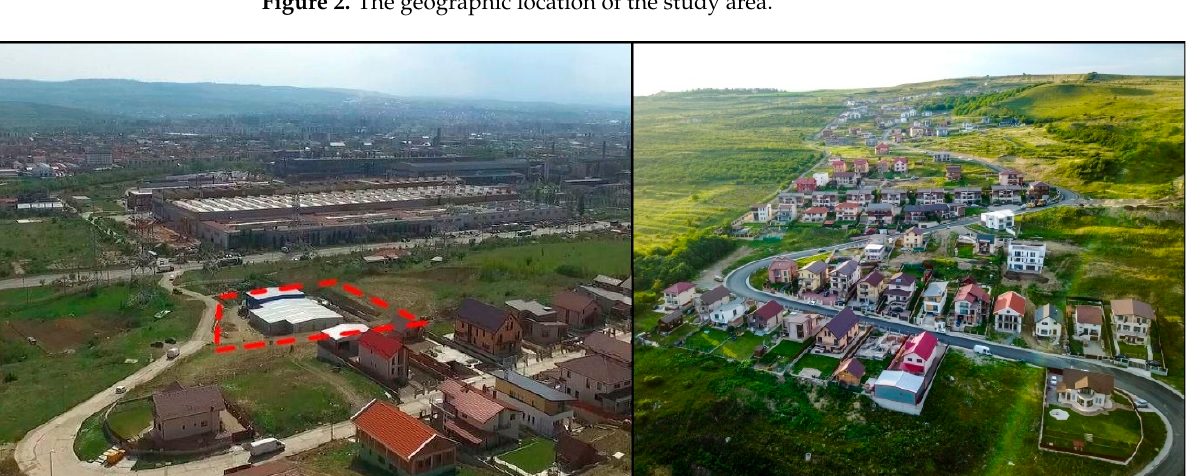
Figure 3. Aerial photos of the emerged residential complex and monitored study area.